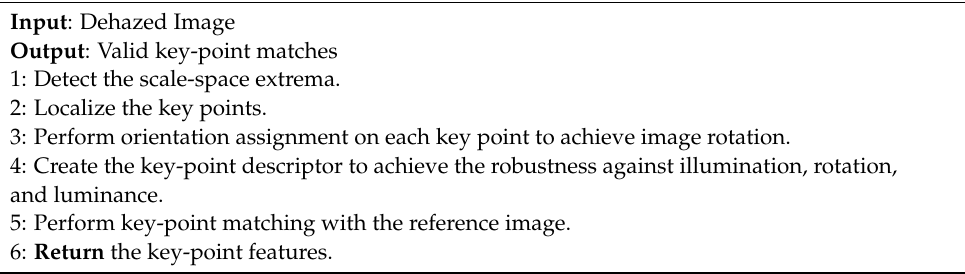
Algorithm 2: Image matching using C-SIFT